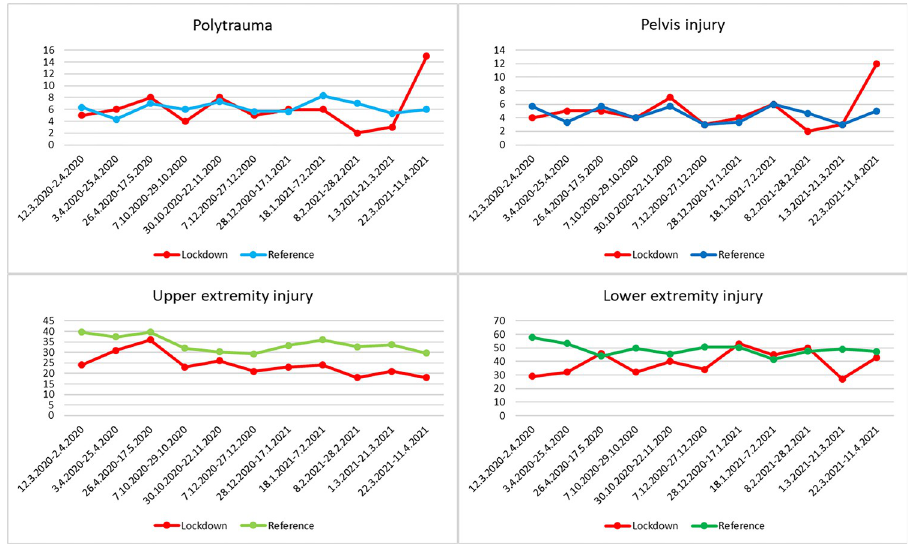
Fig 5. Overview of injuries. Number of individual injuries (y-axis) indicated for surgical treatment in the lockdown period and reference period.